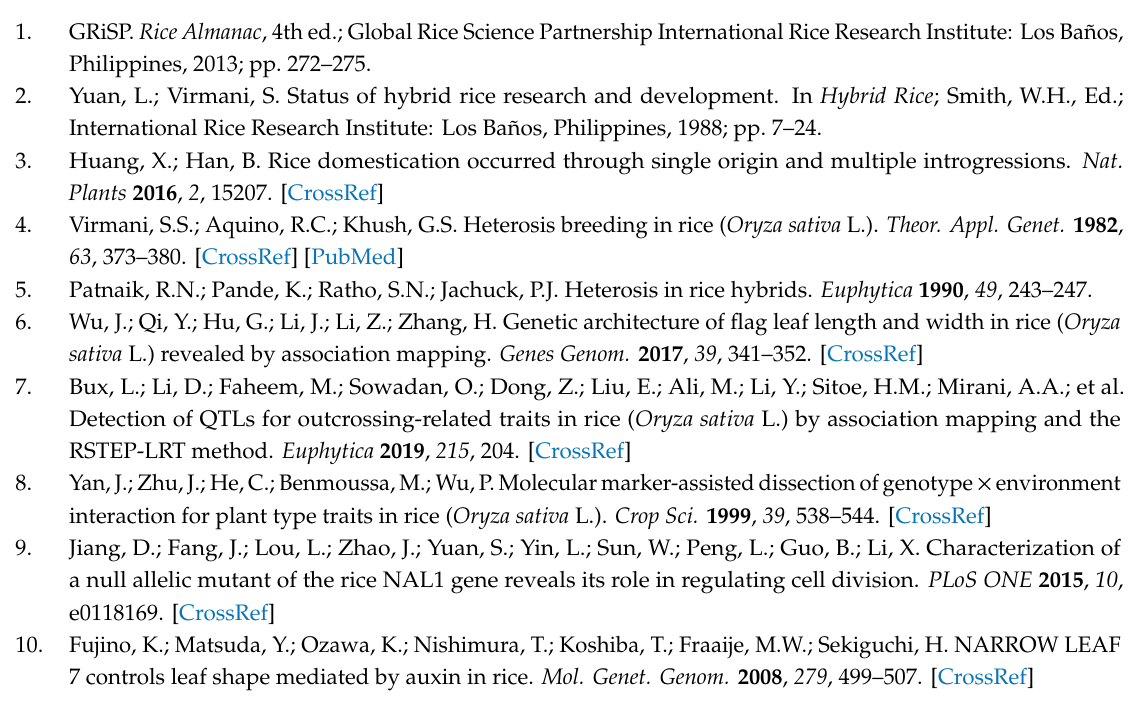
Table S1: Summary information of SSR markers in CL-CSSL population, Table S2: Distribution of donor segments on each line and chromosome in CL-CSSL population, Table S3: Percentage of donor marker segments of 163 lines in the CL-CSSL